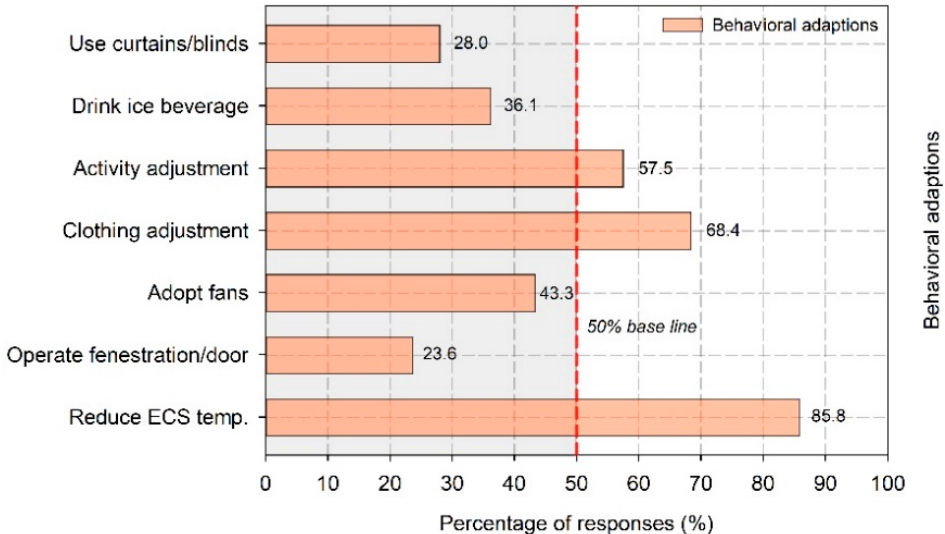
Figure 10. The intent frequency of behavioral adaptions.